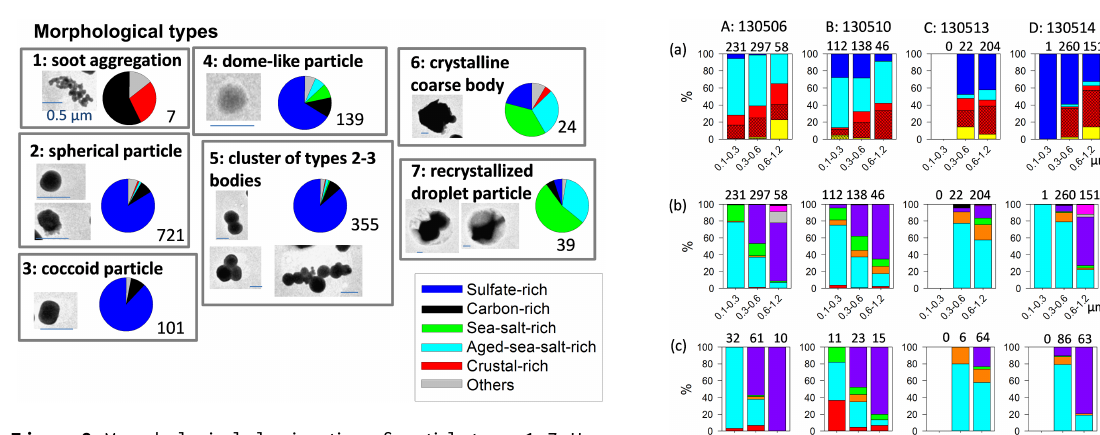
Figure 8. Morphological classification of particle types 1–7. Hor- izontal bars in the photographs represent a length of 0.5µm. The pie chart in each morphological type represents the number frac- tion of compositional types classified based on the EDS analysis. The number below the pie chart represents the number of analyzed particles.